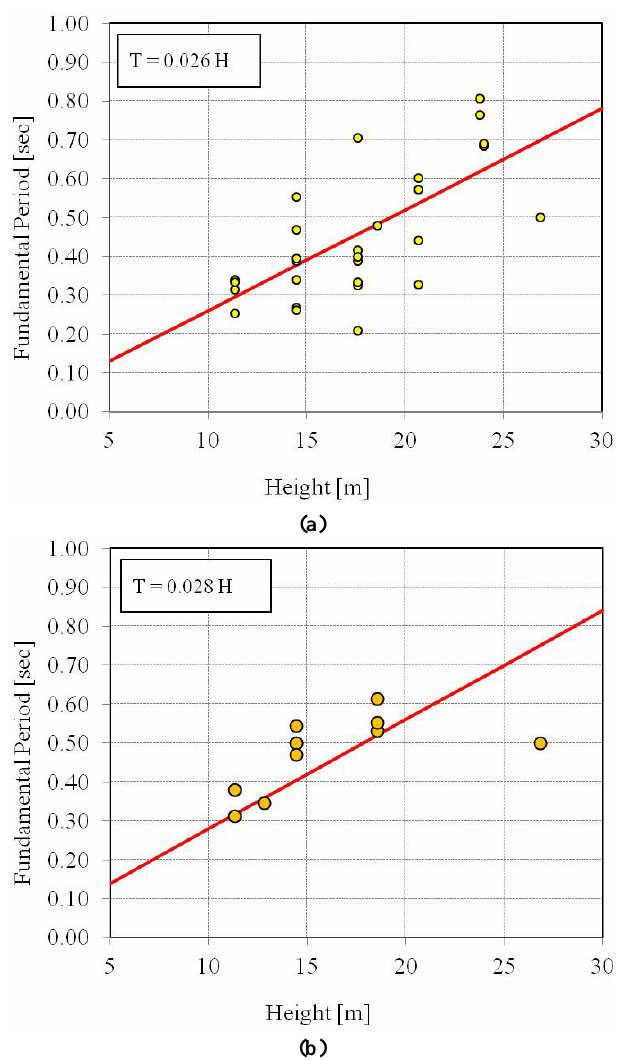
Fig. 6. Correlation between height and period for buildings with damage levels 2 (a) and 3 (b) .